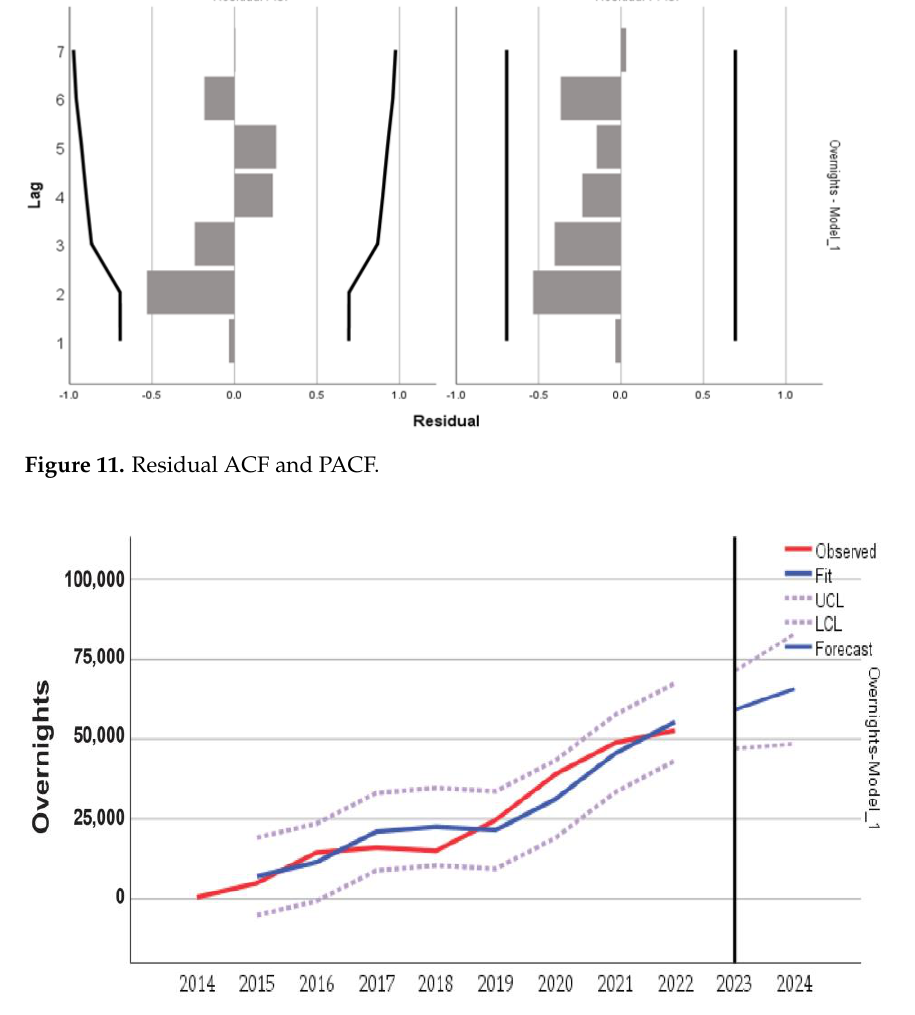
Figure 12. Estimated values of overnight stays for the period 2023 and 2024. Table 6. Forecasting the number of overnight